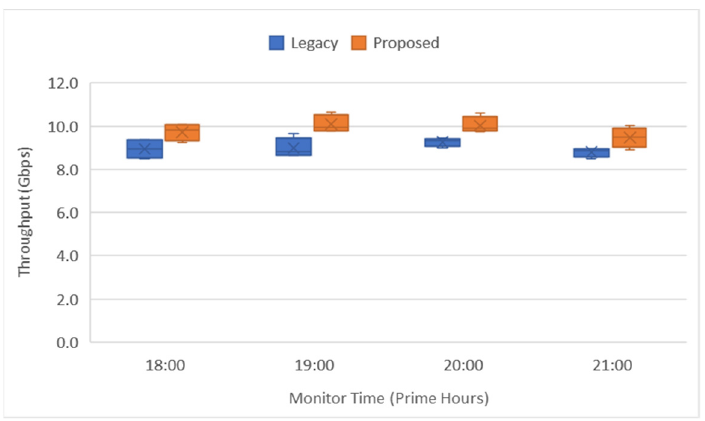
Figure 15. Border leaf switch throughput—All week comparison (output rate). Table 5. Legacy vs. proposed throughput comparison